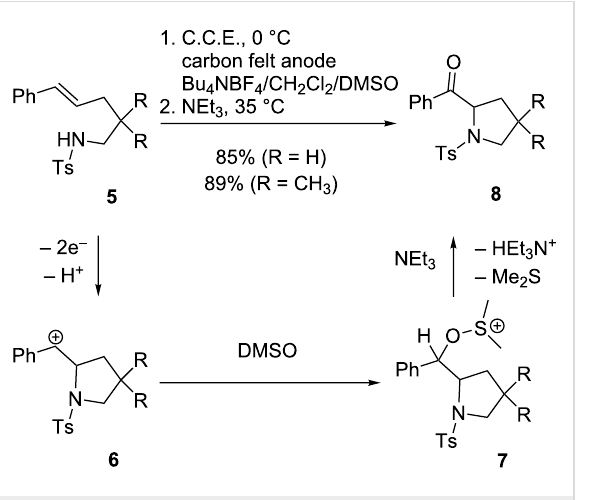
Scheme 3: Anodic cyclization of olefines in CH 2 Cl 2 /DMSO.